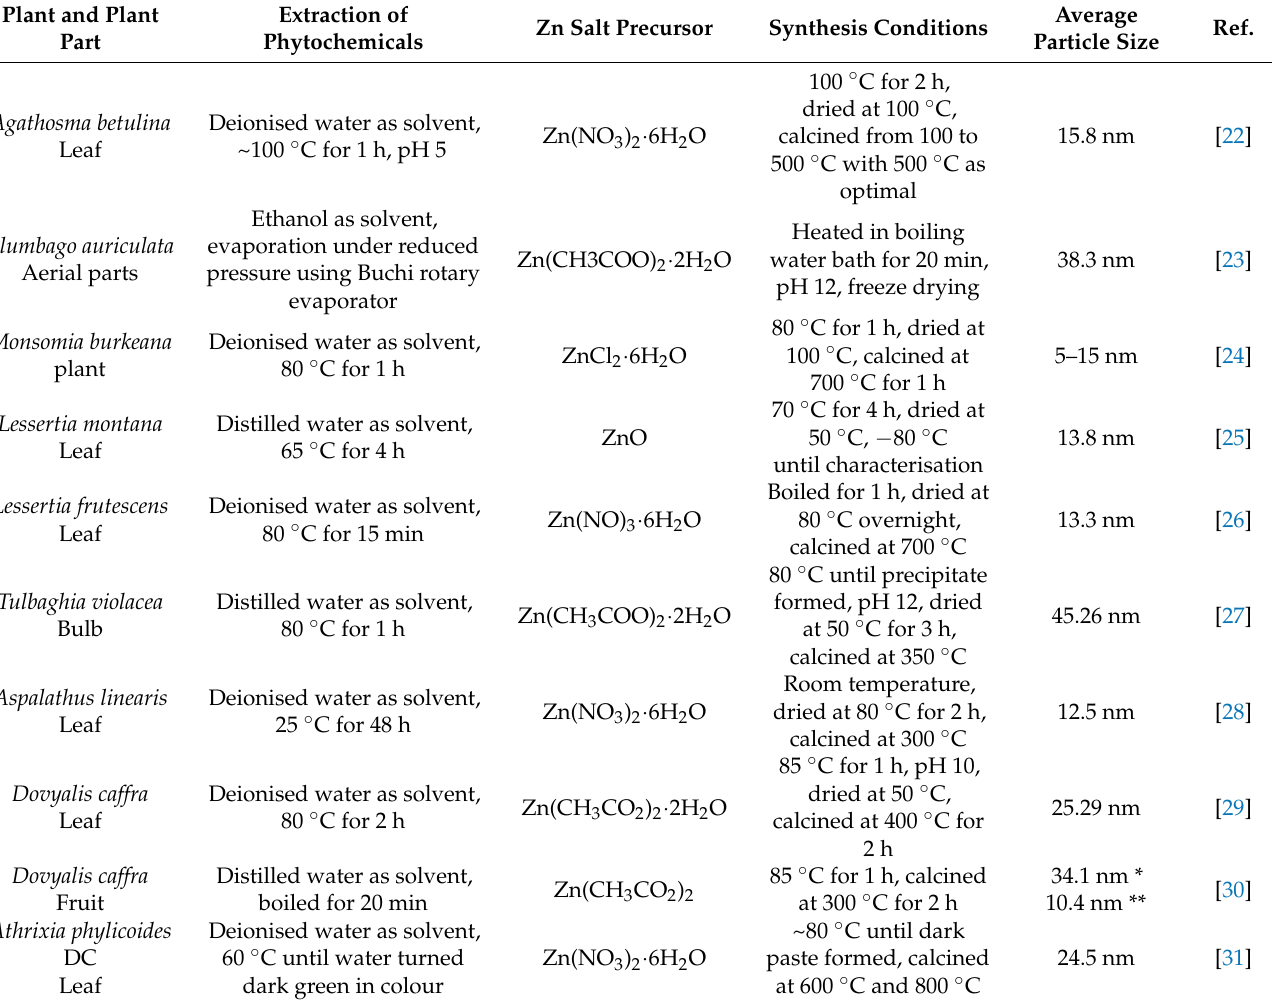
Table 1. List of extraction conditions, Zn salt precursors, synthesis conditions, and average particle sizes ZnO NPs synthesised using some southern African indigenous medicinal